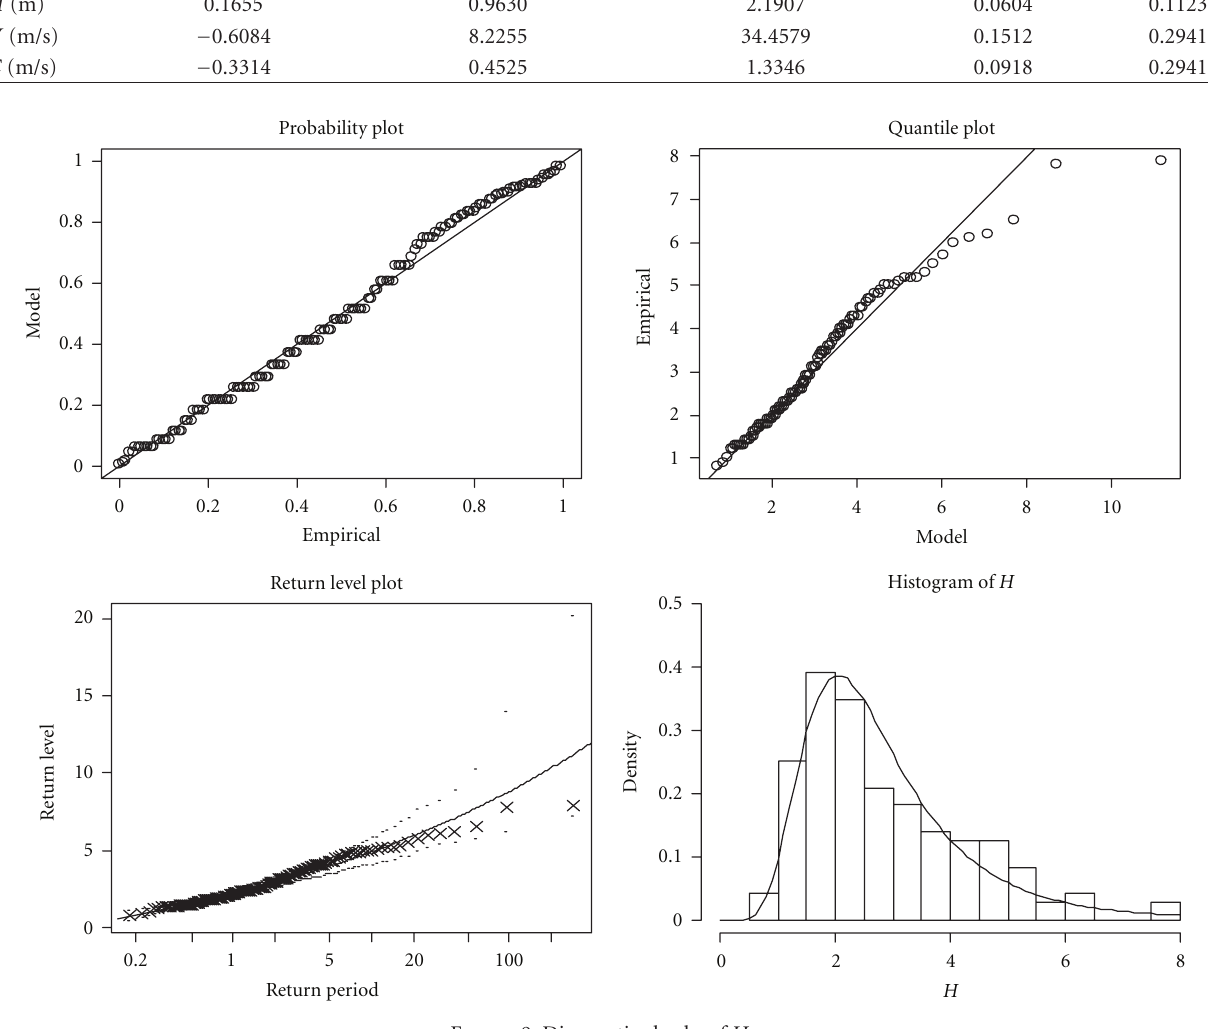
Figure 9: Diagnostic checks of